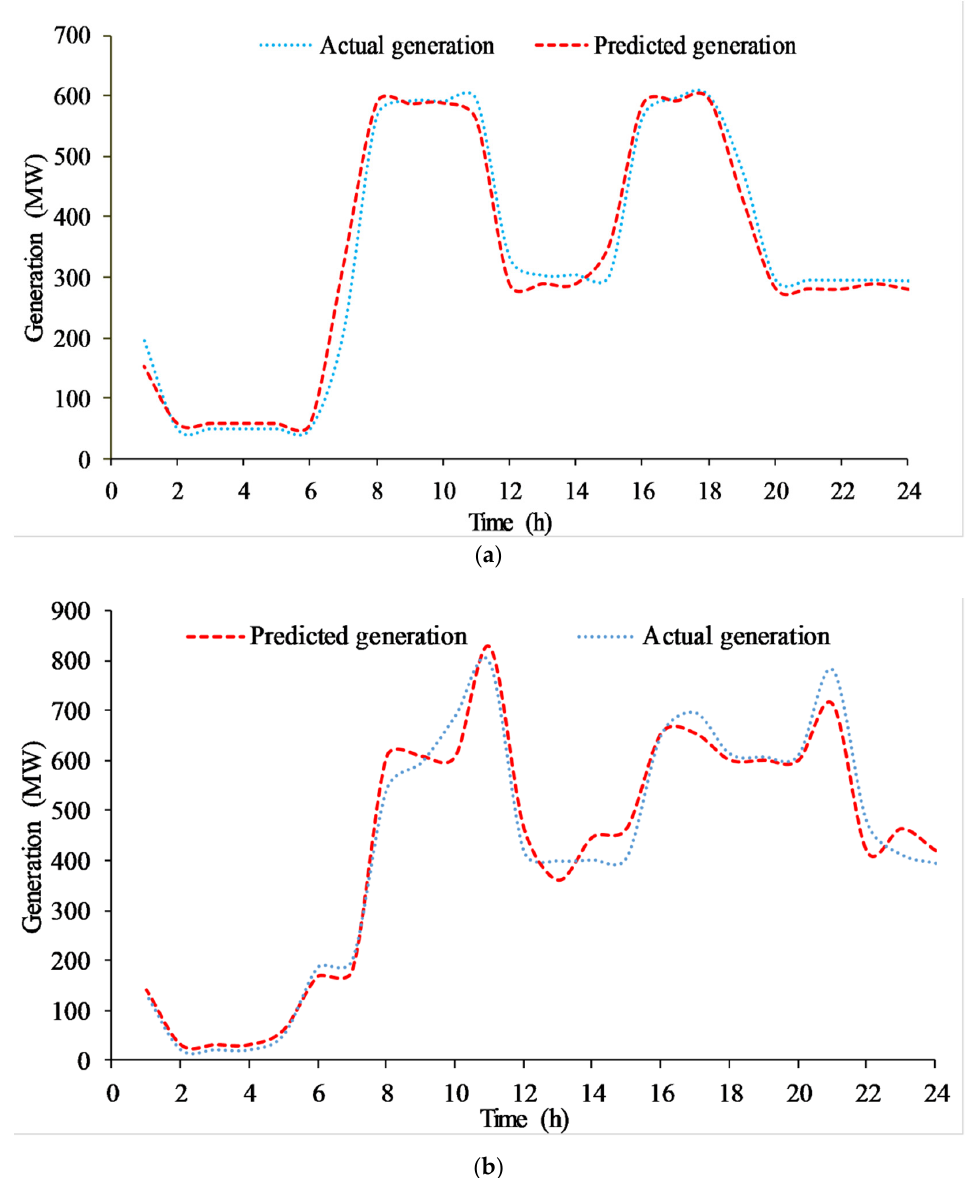
Figure 13. Generation profile of the Tianshengqiao plant 1: ( a ) winter season; ( b ) summer season.